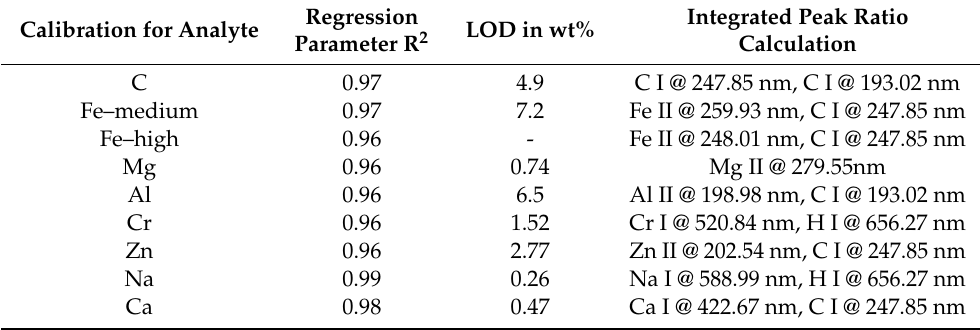
Table 2. Summary of spectral lines used for LIBS signal calculation, calibration of major chemical elements in DPM, obtained regression parameter R 2 , and limit of detection